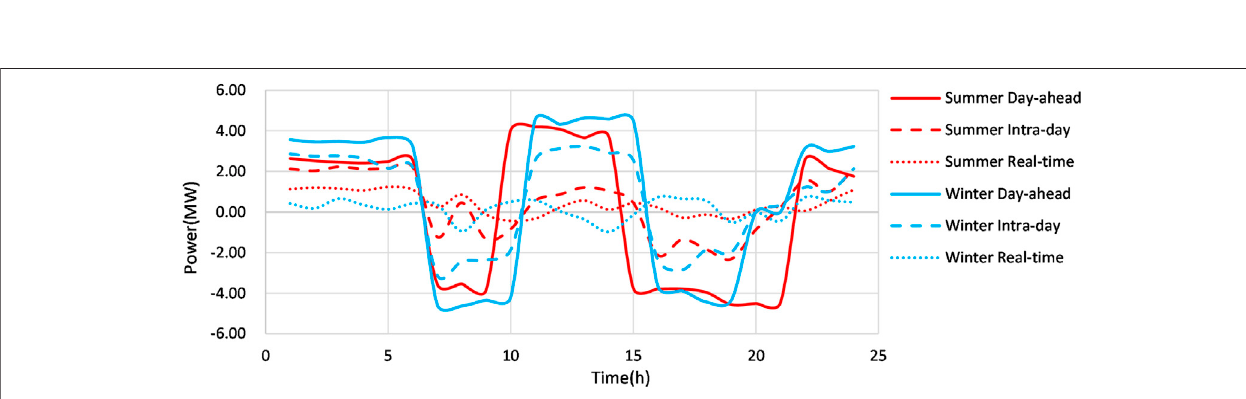
FIGURE 10 | Multi-time scale optimization result of demand response.